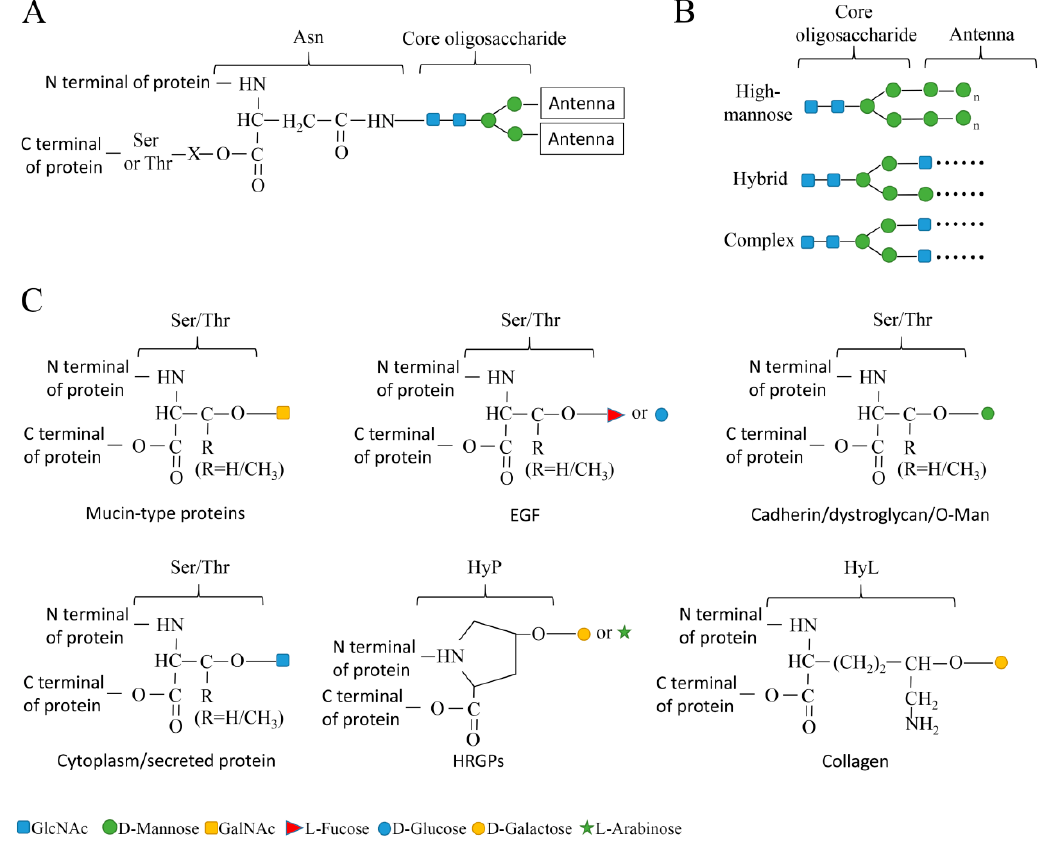
Figure 1. Diagram showing the structure of N -linked and O -linked glycosylation types. ( A ) N -linked glycoprotein. The core oligosaccharide links to the amide nitrogen of asparagine (Asn) in the consensus sequence Asn-X-Ser / Thr (Ser, Thr, and X represent the serine, threonine and random amino acids). ( B ) Di ff erent subtypes of N -glycoproteins. High-mannose, oligosaccharide chains linked to the core oligosaccharide via mannose; Hybrid, oligosaccharide chains linked to the core oligosaccharide via GlcNAc and mannose; Complex, oligosaccharide chains linked to the core oligosaccharide via GlcNAc. ( C ) O -linked glycoprotein, oligosaccharides are bonded to the hydroxyl of Ser, Thr, hydroxylysine (HyL) or hydroxyproline (HyP) of proteins. Although the O -linked glycoprotein has no core oligosaccharide, constant protein-glycans linkage was found in some types of proteins, such as GalNAc-Ser / Thr linkage found in Mucin-type proteins, l -fucose- or d -glucose- Ser / Thr linkage found in epidermal growth-factor-like repeats (EGF), d -mannose- Ser / Thr linkage found in Cadherin, dystroglycan or fungi and prokaryotes glycoproteins (Cadherin / dystroglycan / O-Man), GlcNAc- Ser / Thr linkage found in nucleocytosol glycoproteins or secreted glycoproteins in eukaryotic cells except yeast (Cytoplasm / secreted protein), d -galactose- or l -arabinose- HyP linkage found in hydroxyproline-rich glycoproteins (HRGPs) and d -galactose- HyL linkage found in Collagen.